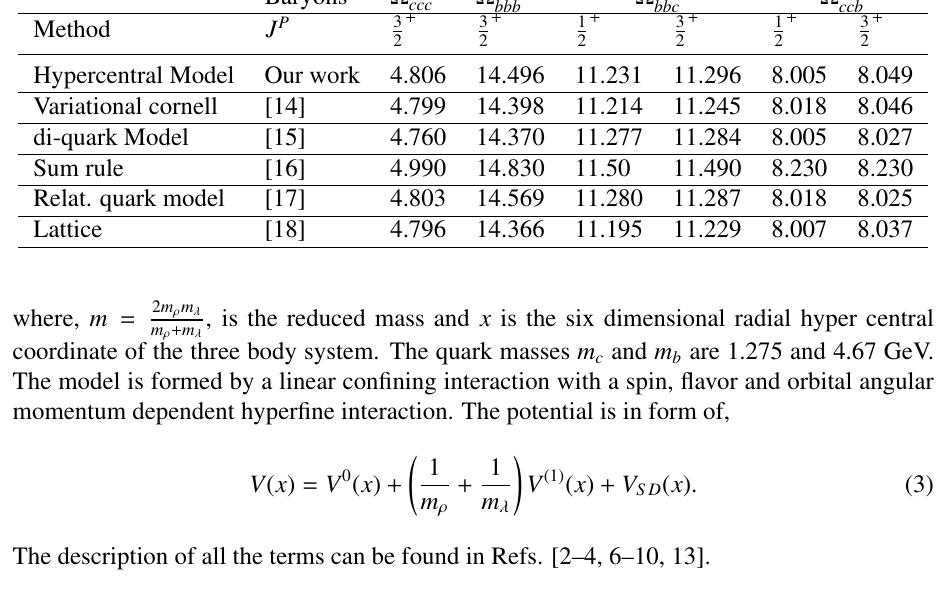
Table 1. Ground state masses of triply heavy baryons (in GeV) Baryons